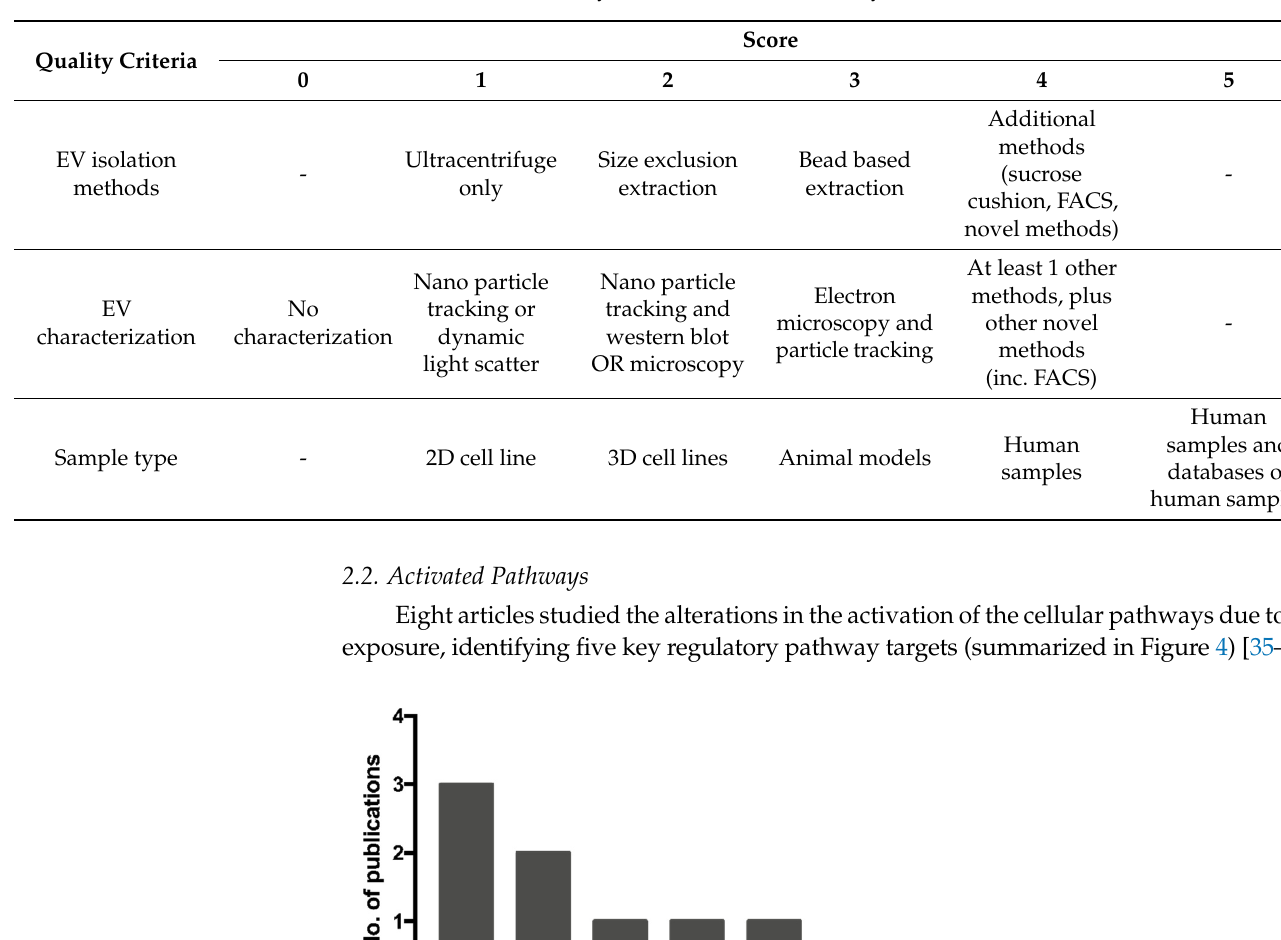
Table 1. Quality assessment score summary.